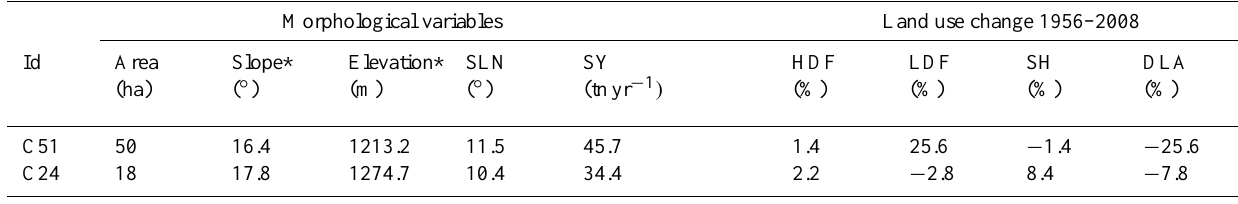
Table 1. Morphological and land use change characteristics of study subcatchments C24 and C51 (positive land use change values indicate increase in 2008 and viceversa). SLN: average slope of the drainage network, SY: sediment yield, HDF: high density forest, LDF: low density forest, SH: shrubland, DLA: dry-land agriculture, *average values reported.